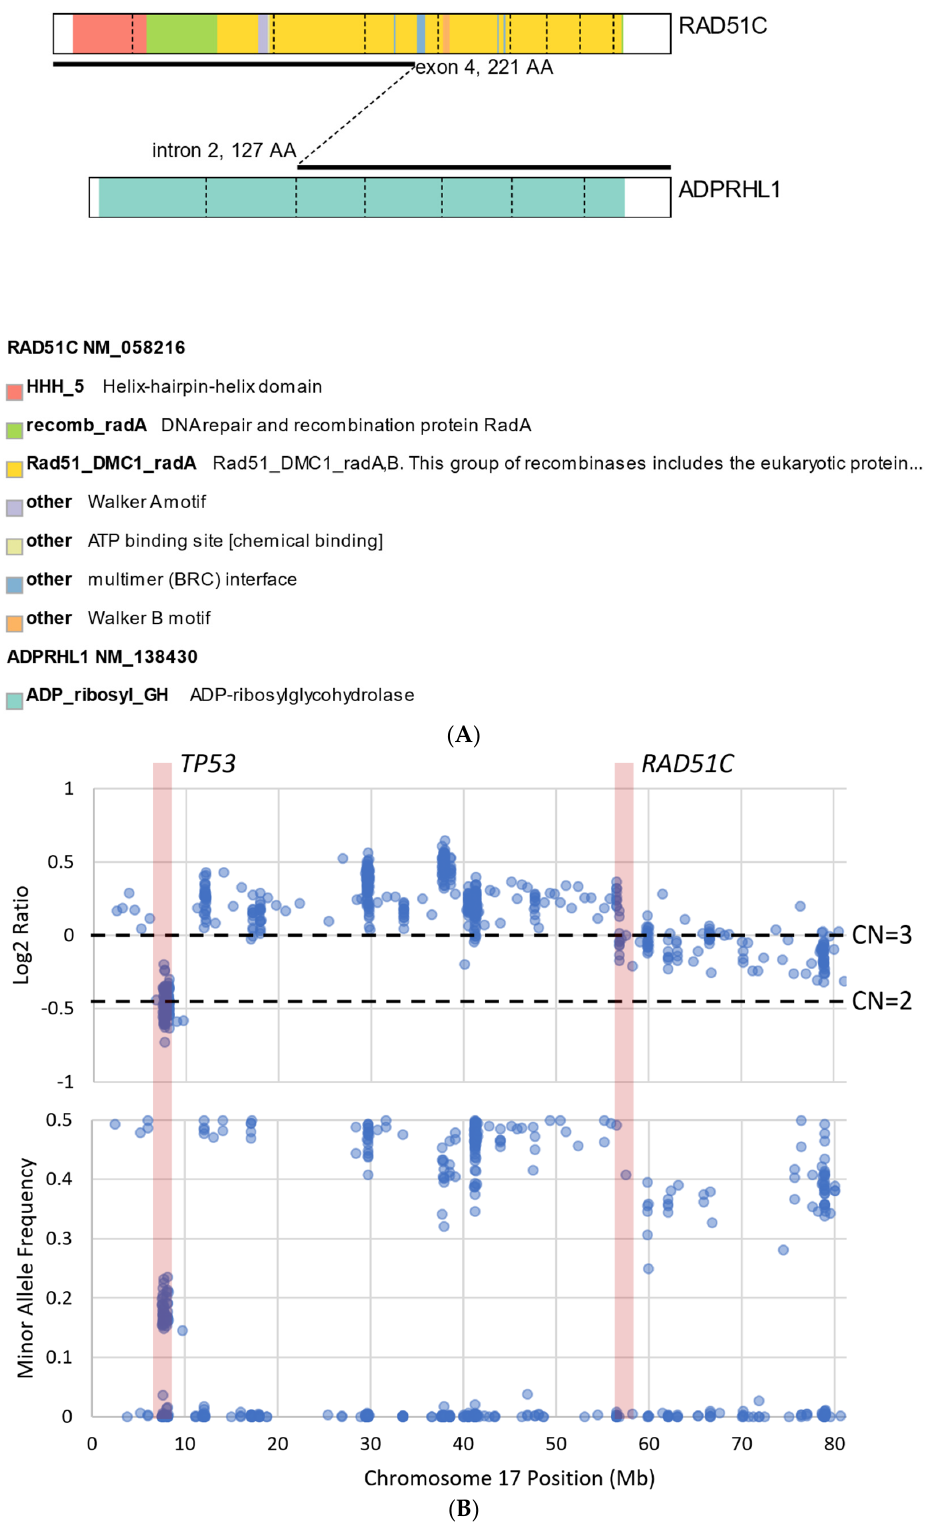
Figure 3. Graphical illustration of RAD 51C mutation from the same patient presented in Figure 2. ( A ) Translocation t(13;17) with chromosome 17 breakpoint identified in exon 4 of RAD 51C. ( B ) Examination of chromosome 17 copy number data shows a copy number transition accompanying LOH with a breakpoint at the RAD 51C locus, suggesting likely loss of the second allele.